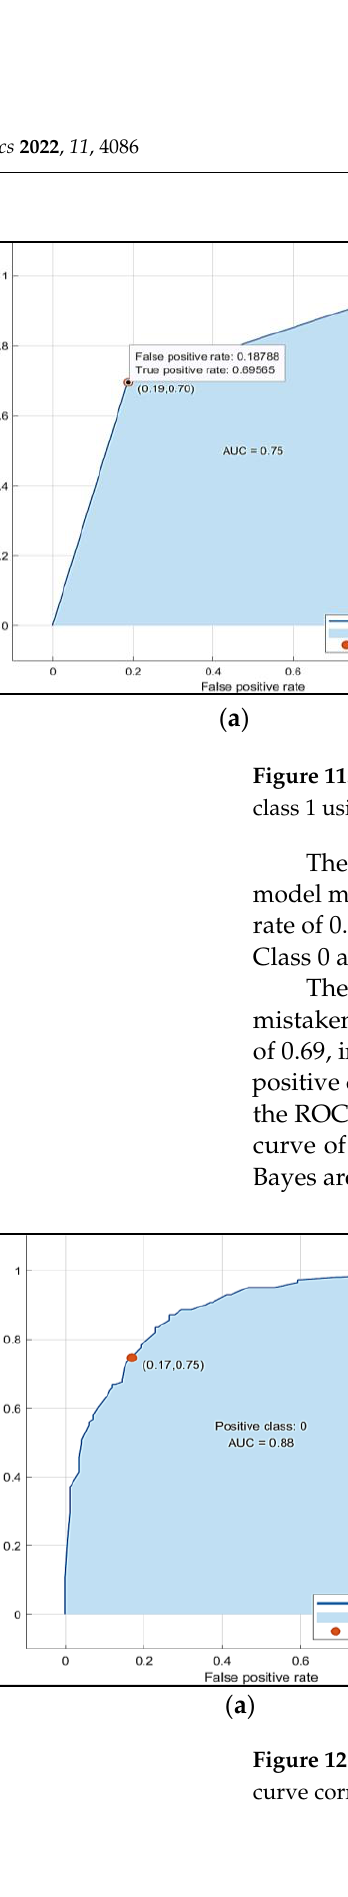
( b ) Figure 14. ( a ) Gaussian naive Bayes model ROC curve corresponds to class 0. ( b ) Gaussian naive Bayes model ROC curve corresponds to class 1.